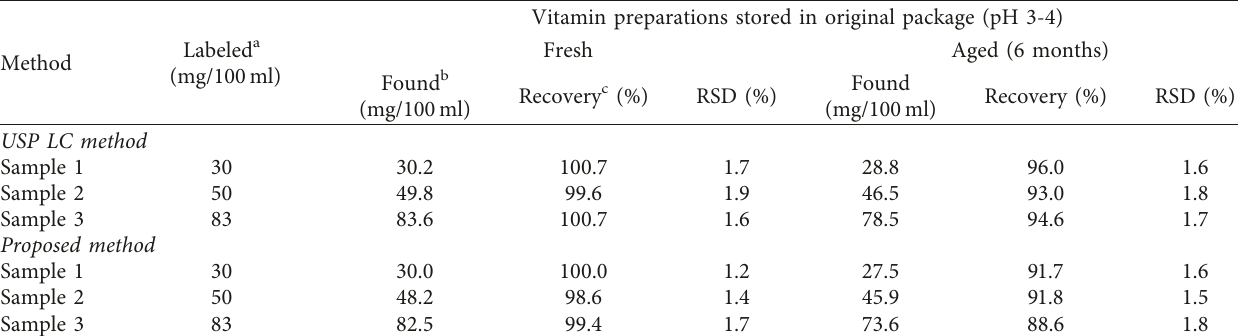
Table 4: Assay of TH in vitamin preparations (25 ± 1 °